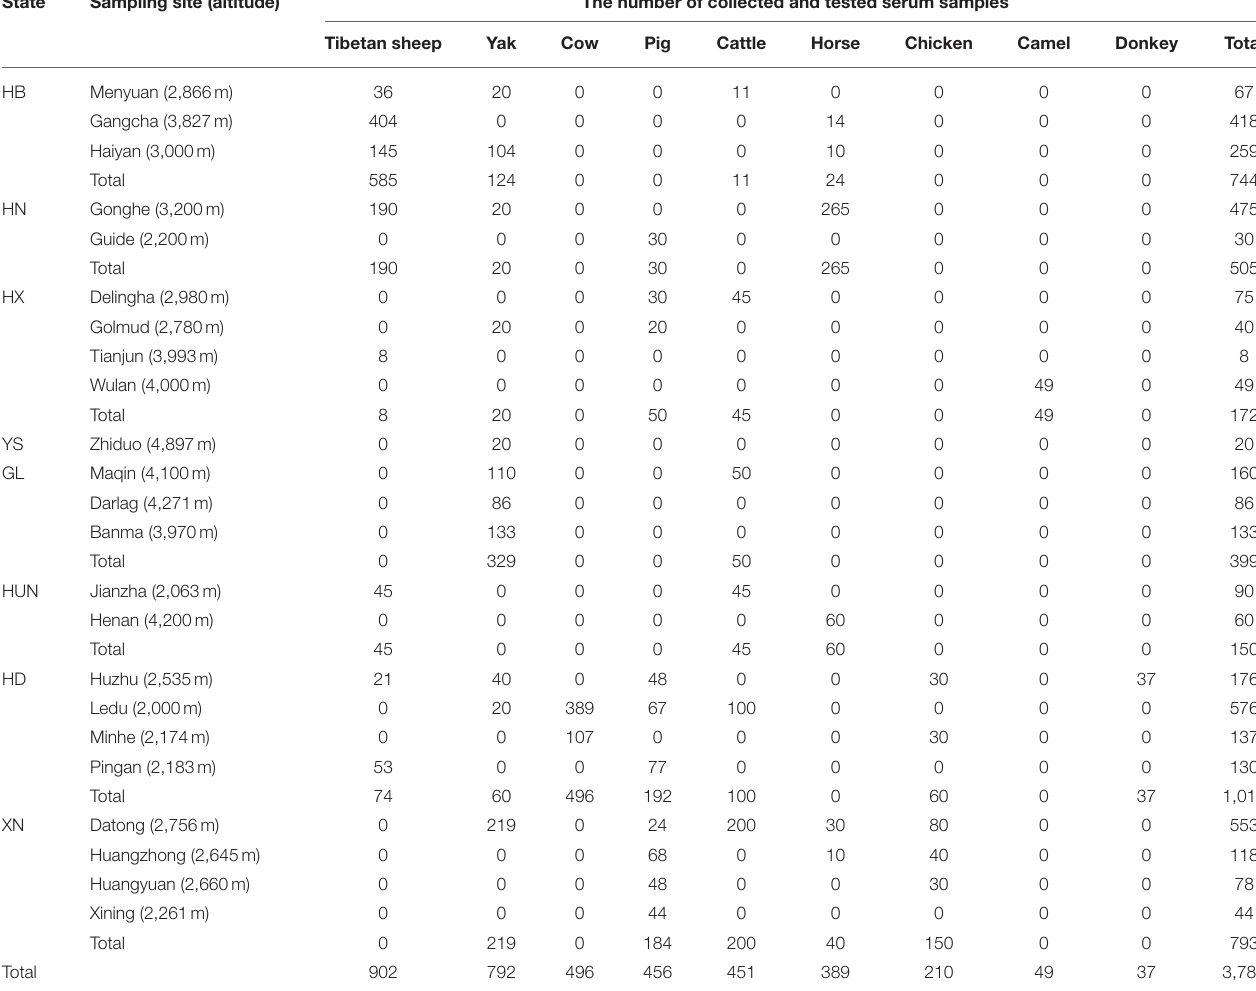
TABLE 1 | The sampling sites of animals in the QTPA in this study. State Sampling site